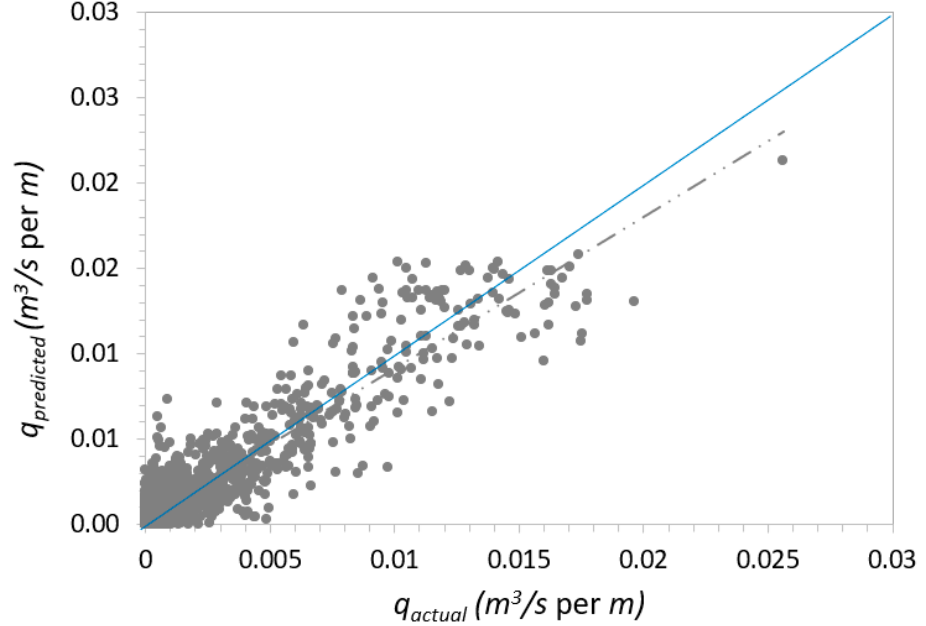
Figure 12. Scatter plot of the measured and predicted wave-overtopping values of the ANN model by van Gent et al. (2007).